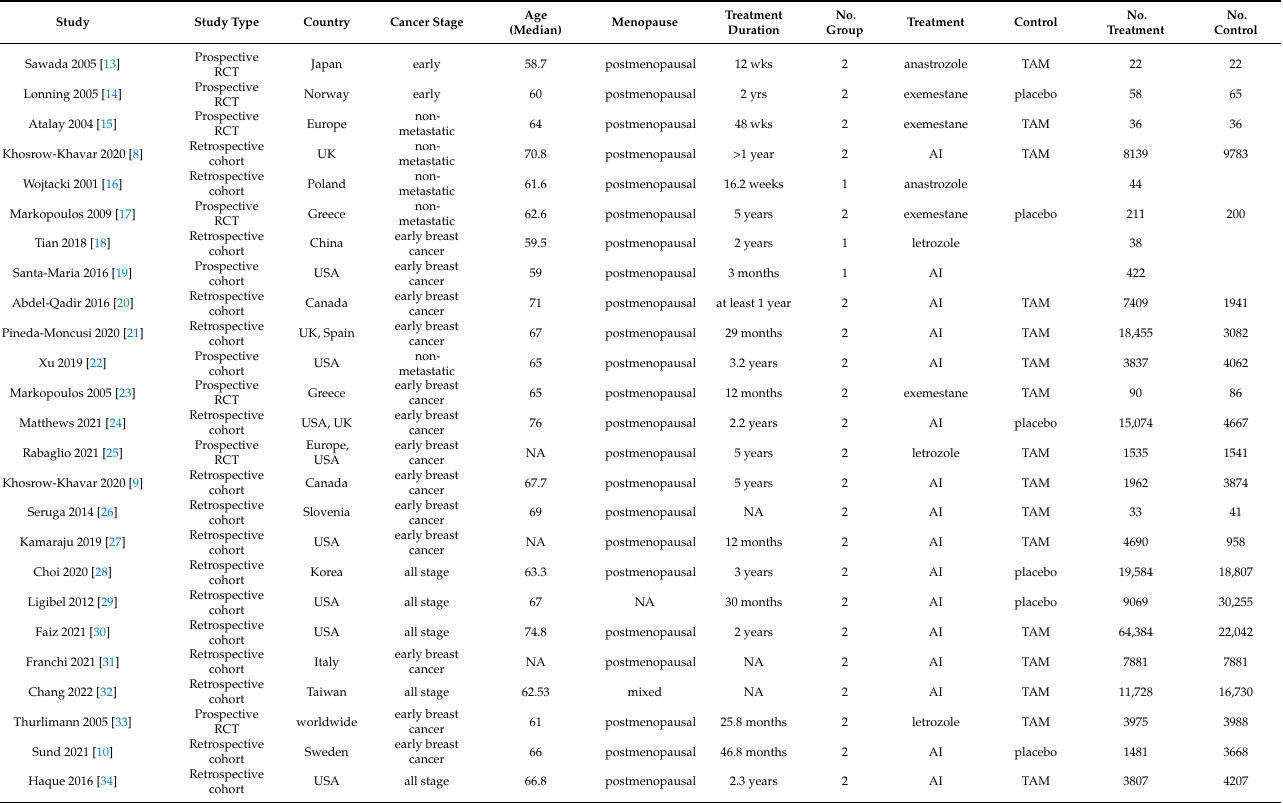
Table 1. Demographics and characteristics of studies included in the systematic review and meta-analysis.